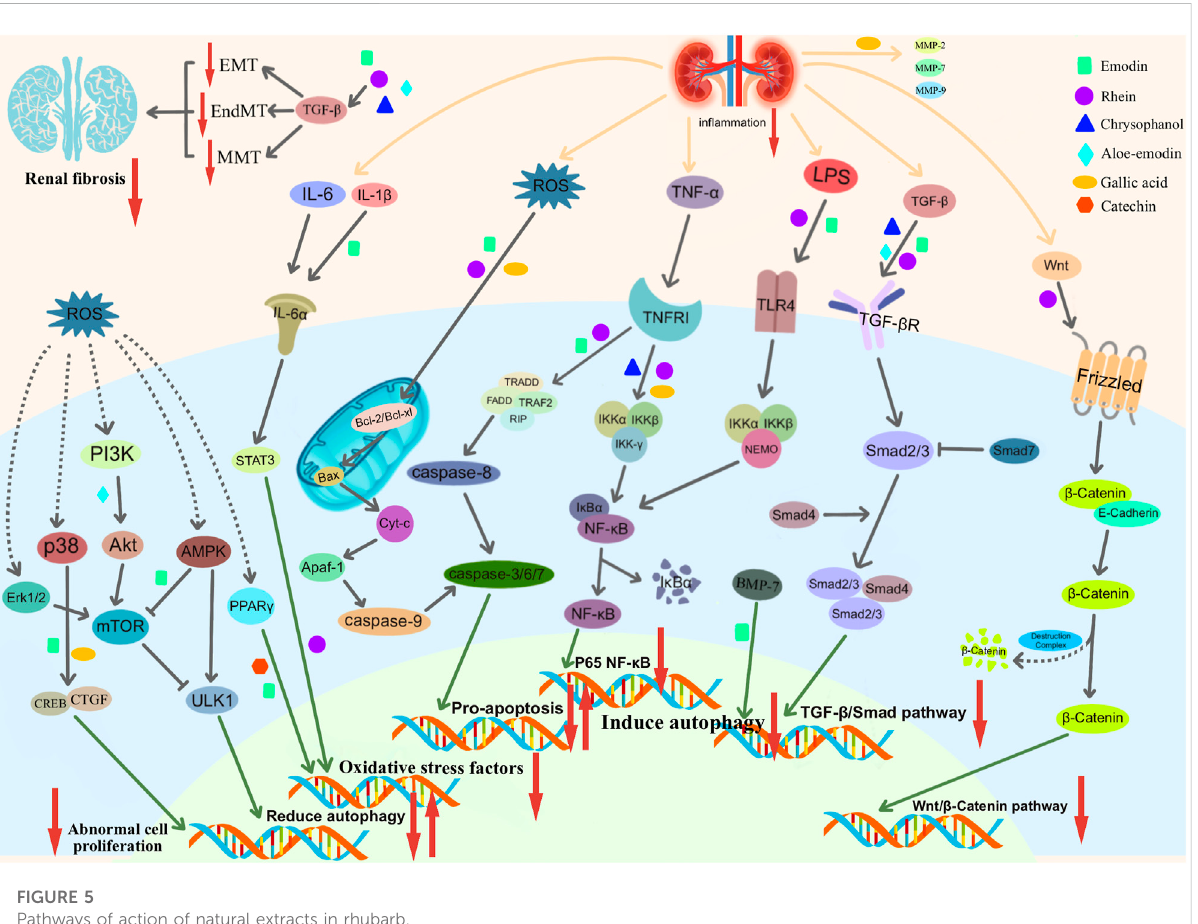
FIGURE 5 Pathways of action of natural extracts in